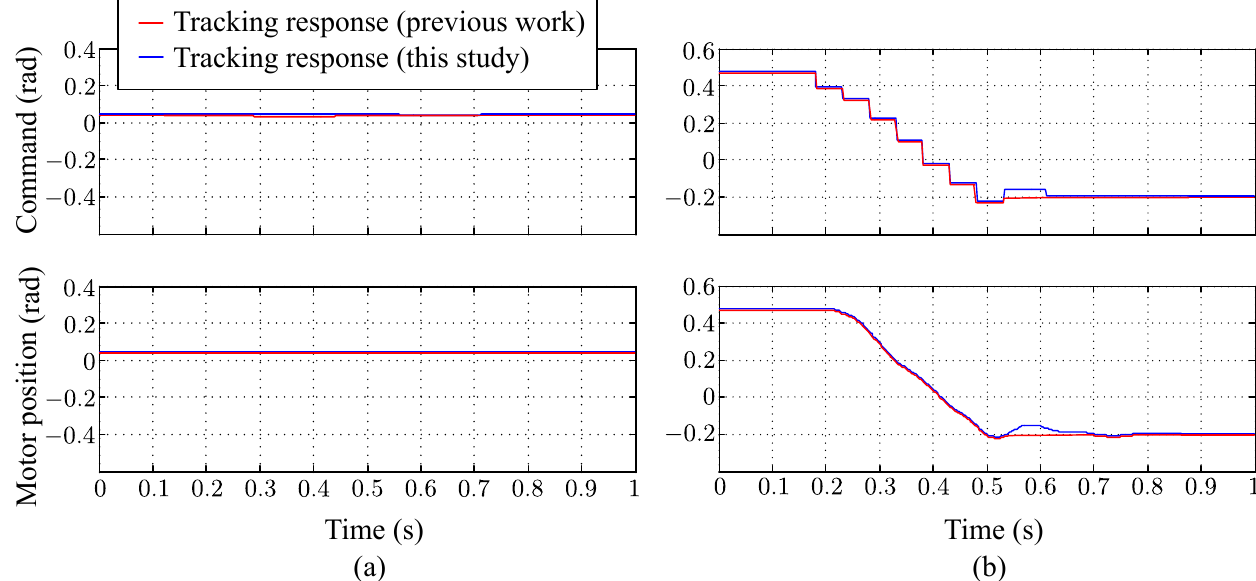
Figure 18. A free falling ball: tracking response of ( a ) the pan-axis motor and ( b ) the tilt-axis